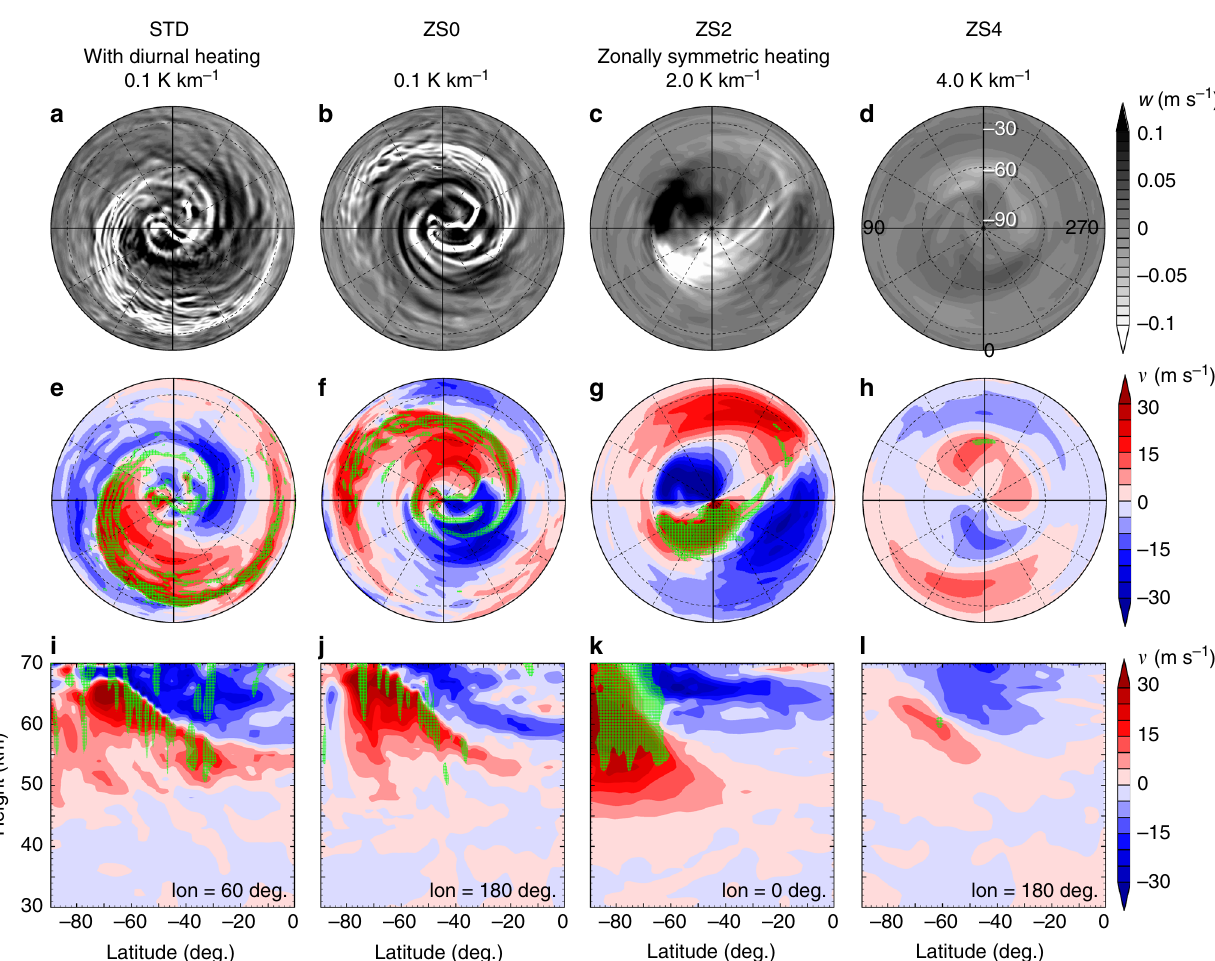
Fig. 4 Results of the numerical experiments. Settings are shown on the top of the fi gure. Panels a – d show snapshots of vertical velocity at the altitude of 60 km, and e – h show those of meridional velocity seen from the south pole in the model; i – l are meridional cross-sections of meridional velocity. Green hatching indicates strong downward fl ow ( w < − 0.05 m s − 1 ). In i – l , the longitude of the meridional cross-section is shown in each panel